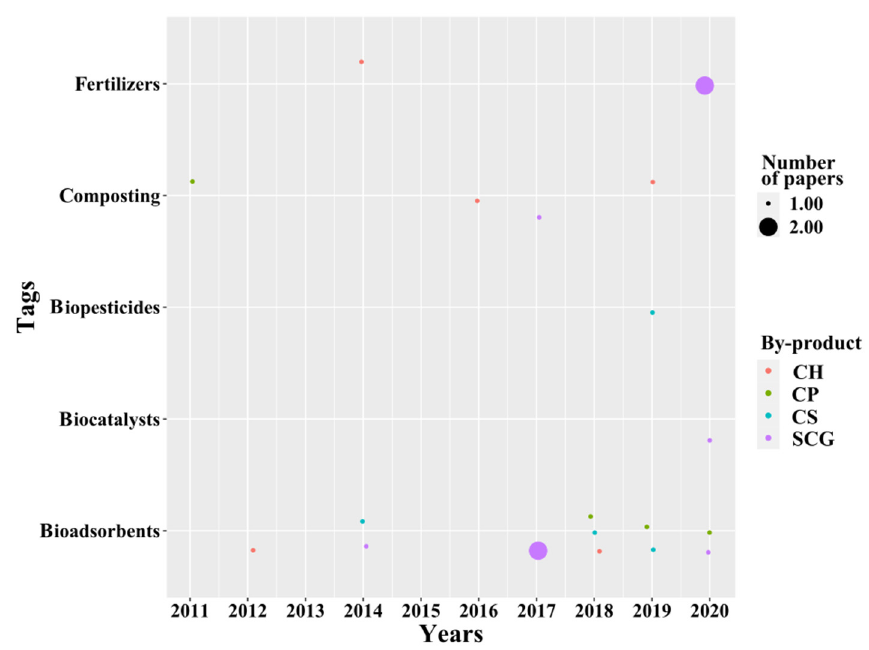
Figure 9. Temporal analysis of microbial transformation applications.